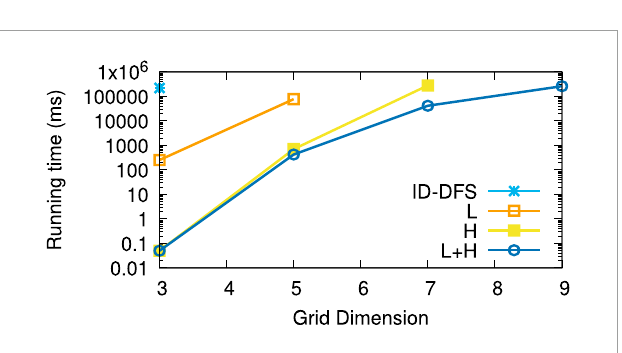
FIGURE 11 Average running times (in ms) for the type (f) (wide labyrinth)